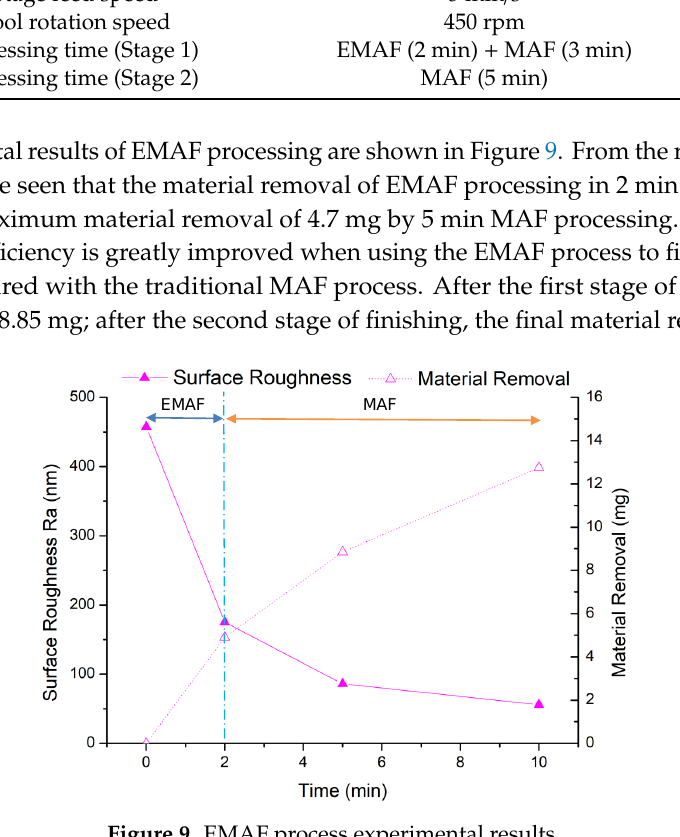
Figure 9. EMAF process experimental results.